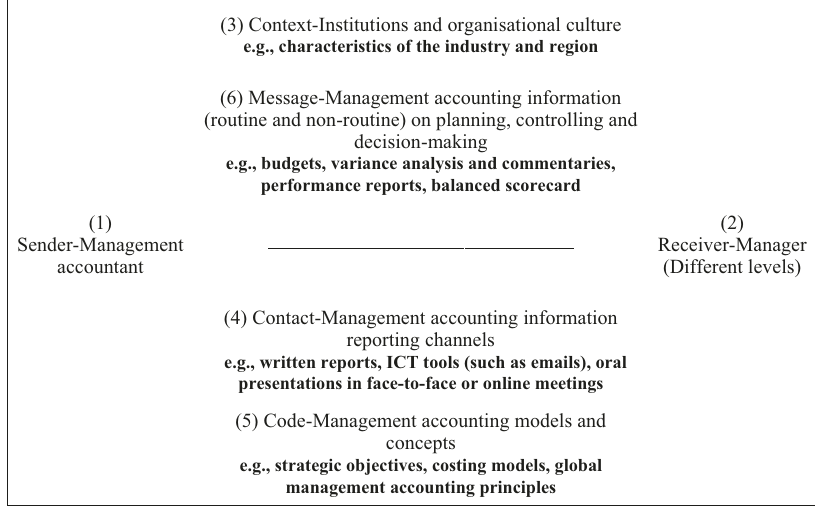
Fig. 6 Communication model of management accounting. Source: Prepared by the